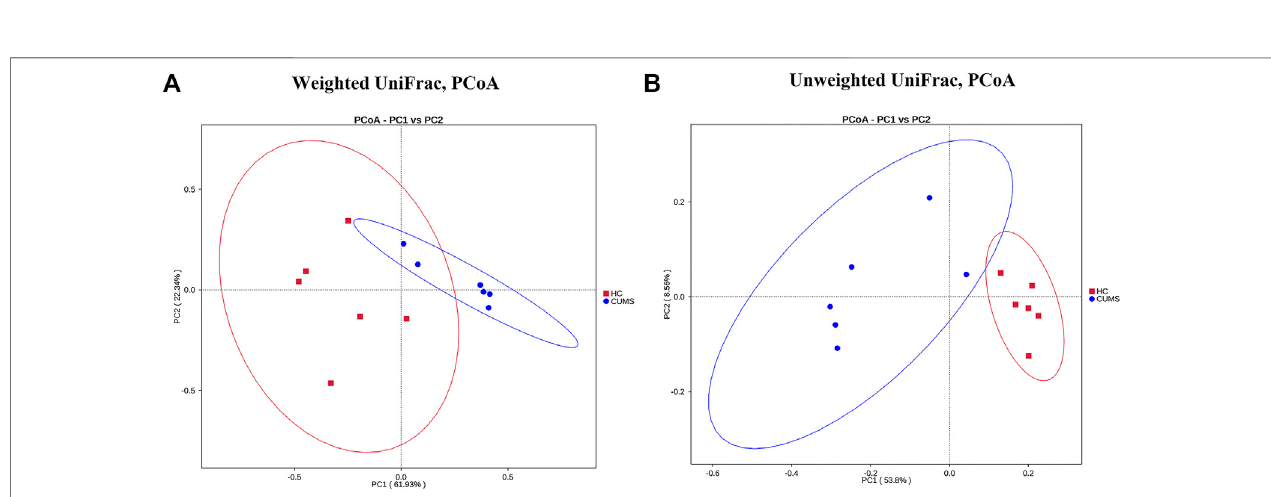
FIGURE 4 | PCoA plots of bacterial beta-diversity on the basis of Weighted UniFrac distance (A) and the Unweighted UniFrac distance (B) . HC (red circles) vs CUMS (blue circles) groups.